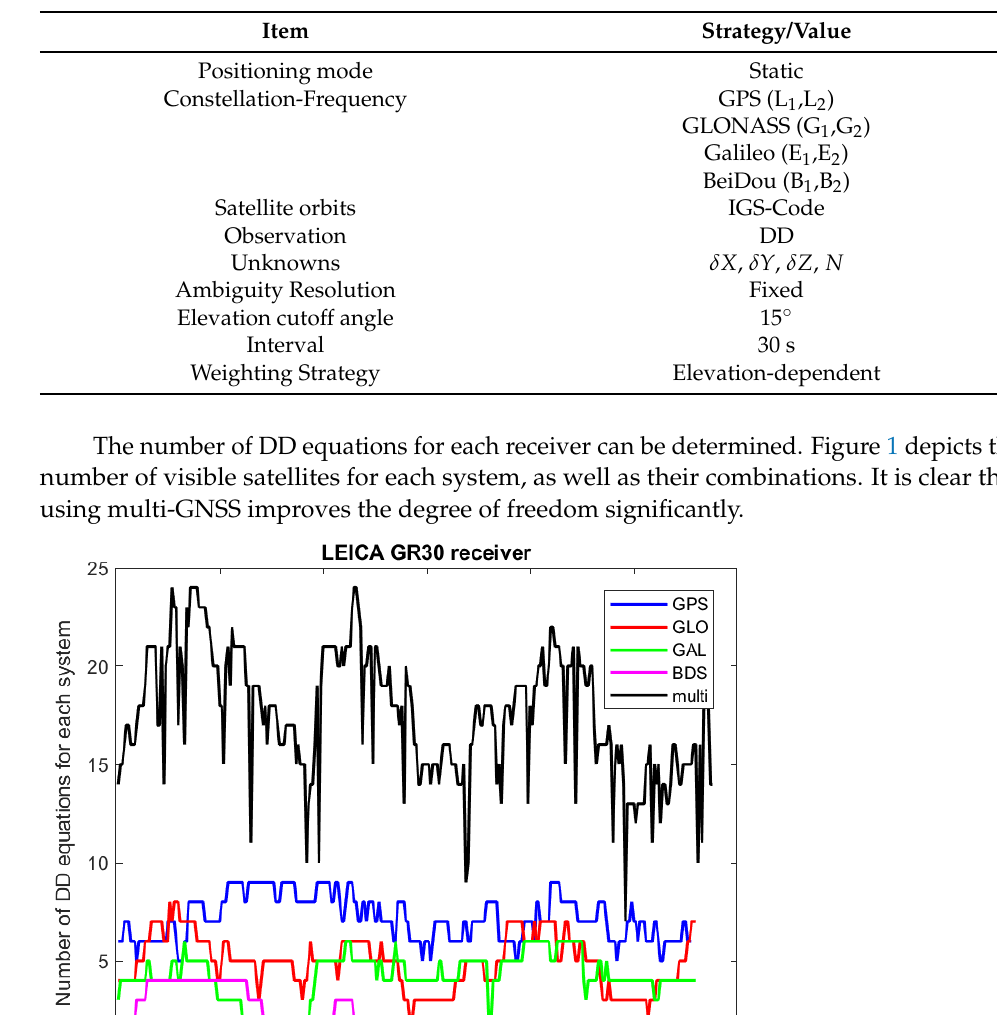
Table 1. Summary of the strategy of data processing.